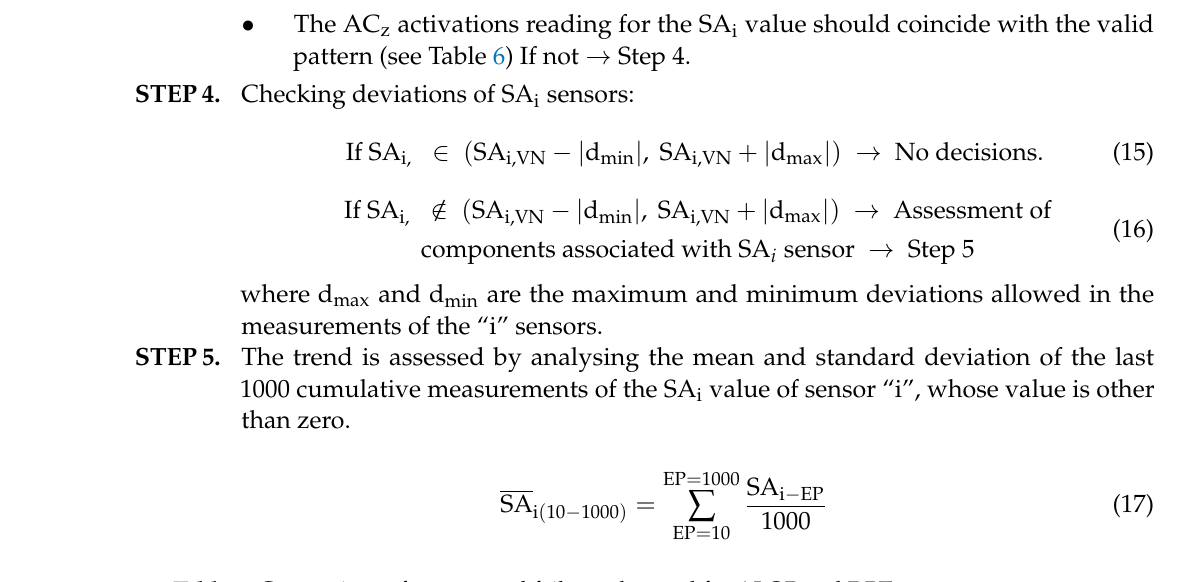
Table 6. Comparison of unexpected failures detected for ALOP and